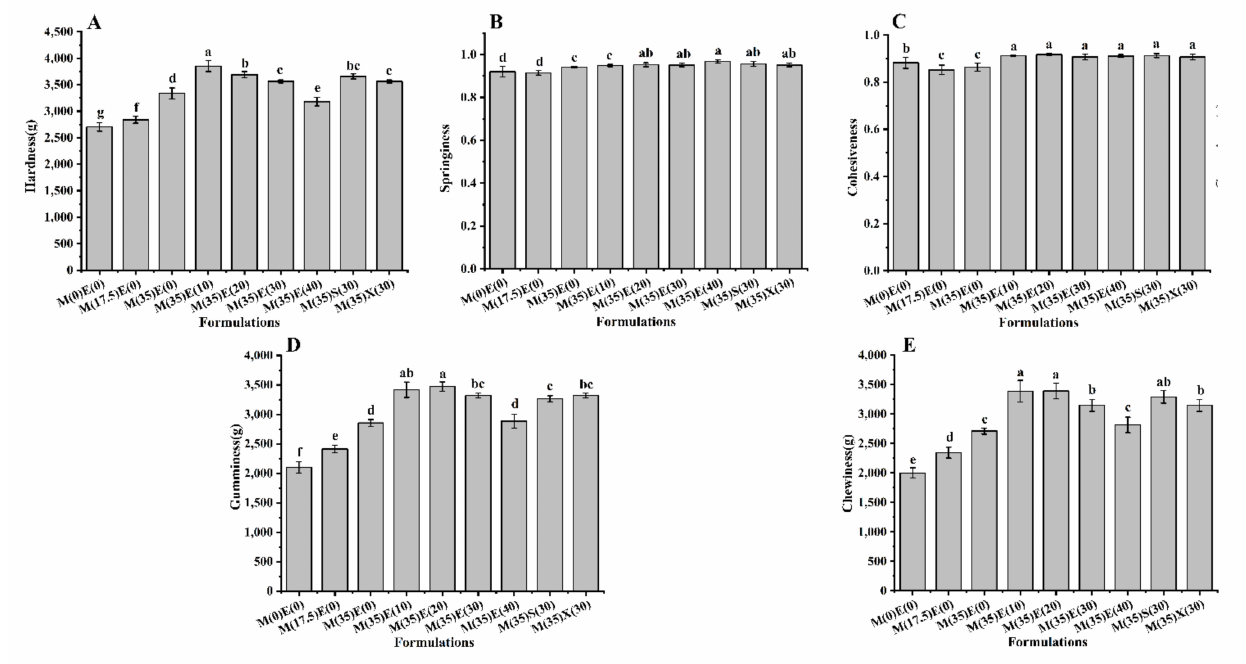
Figure 6. Textural properties with different formulation inks. ( A ) Hardness; ( B ) Springiness; ( C ) Co- hesiveness; ( D ) Gumminess; ( E ) Chewiness. Different lowercase letters denote significant differences ( p <